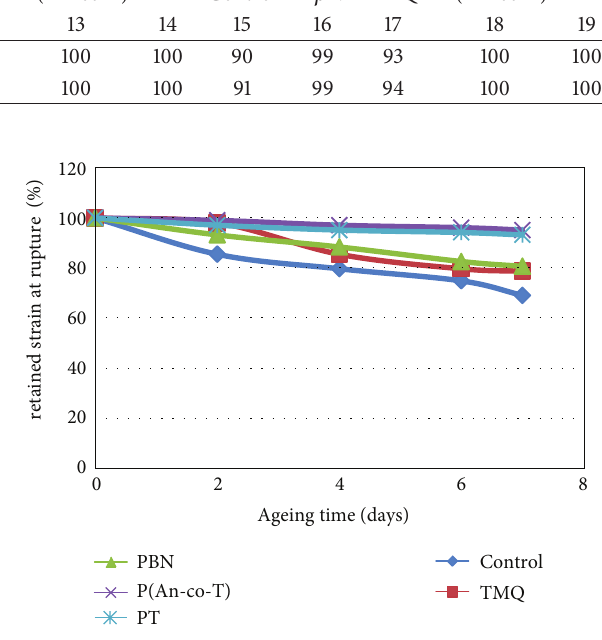
Table 7: Retained stress and strain at rupture for NR and SBR vulcanizates containing the commercial antioxidants P 𝛽 N, TMQ and prepared polymers of P(An-co-T) and PT after exposure to UV irradiation for 72 hr. Formulation property